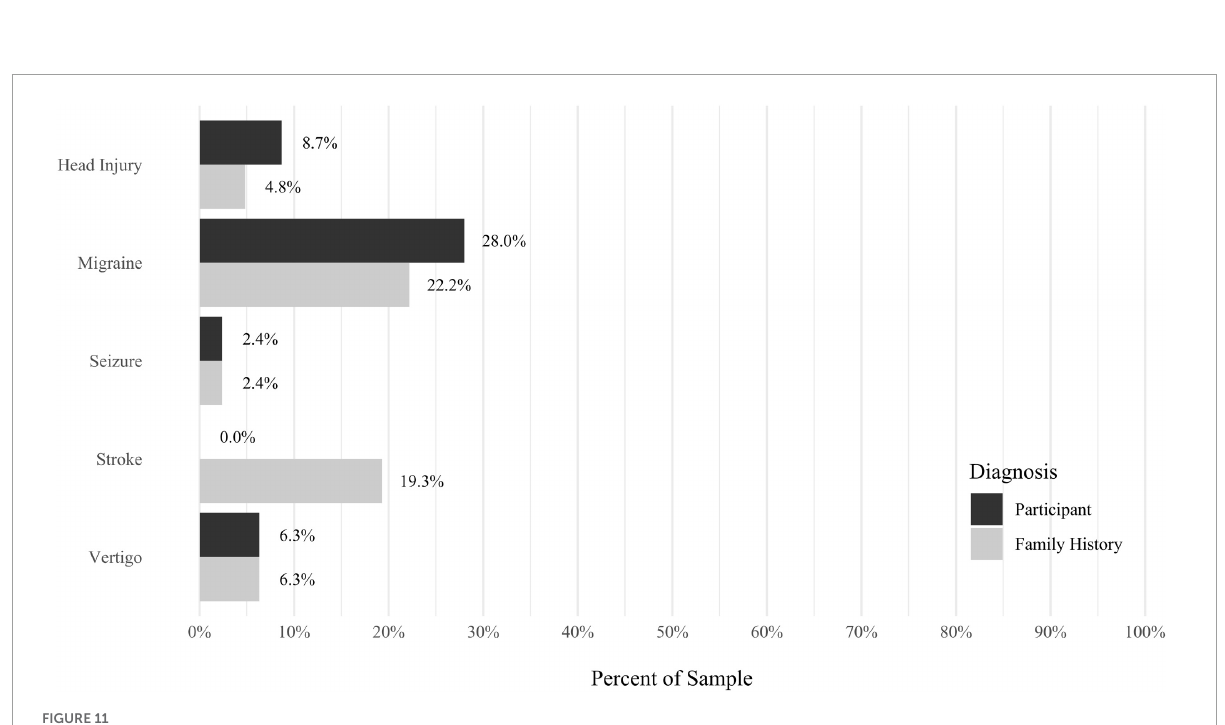
FIGURE10 Rates of medical health problems: neurocognitive disorders.